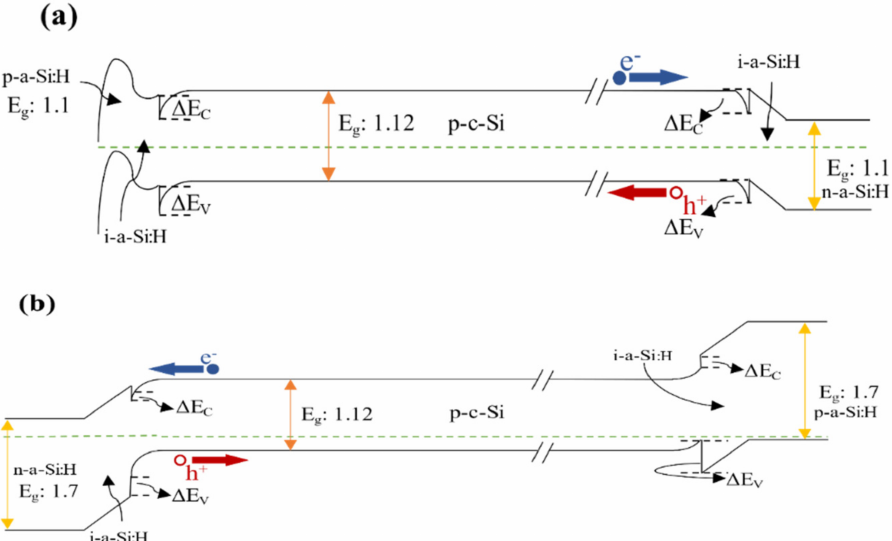
Figure 5. ( a ) The corresponding band diagram of structure p-i-n with p-type wafer when E g = 1.1 and χ = 4. ( b ) The corresponding band diagram of structure n-i-p when E g = 1.7 and χ =